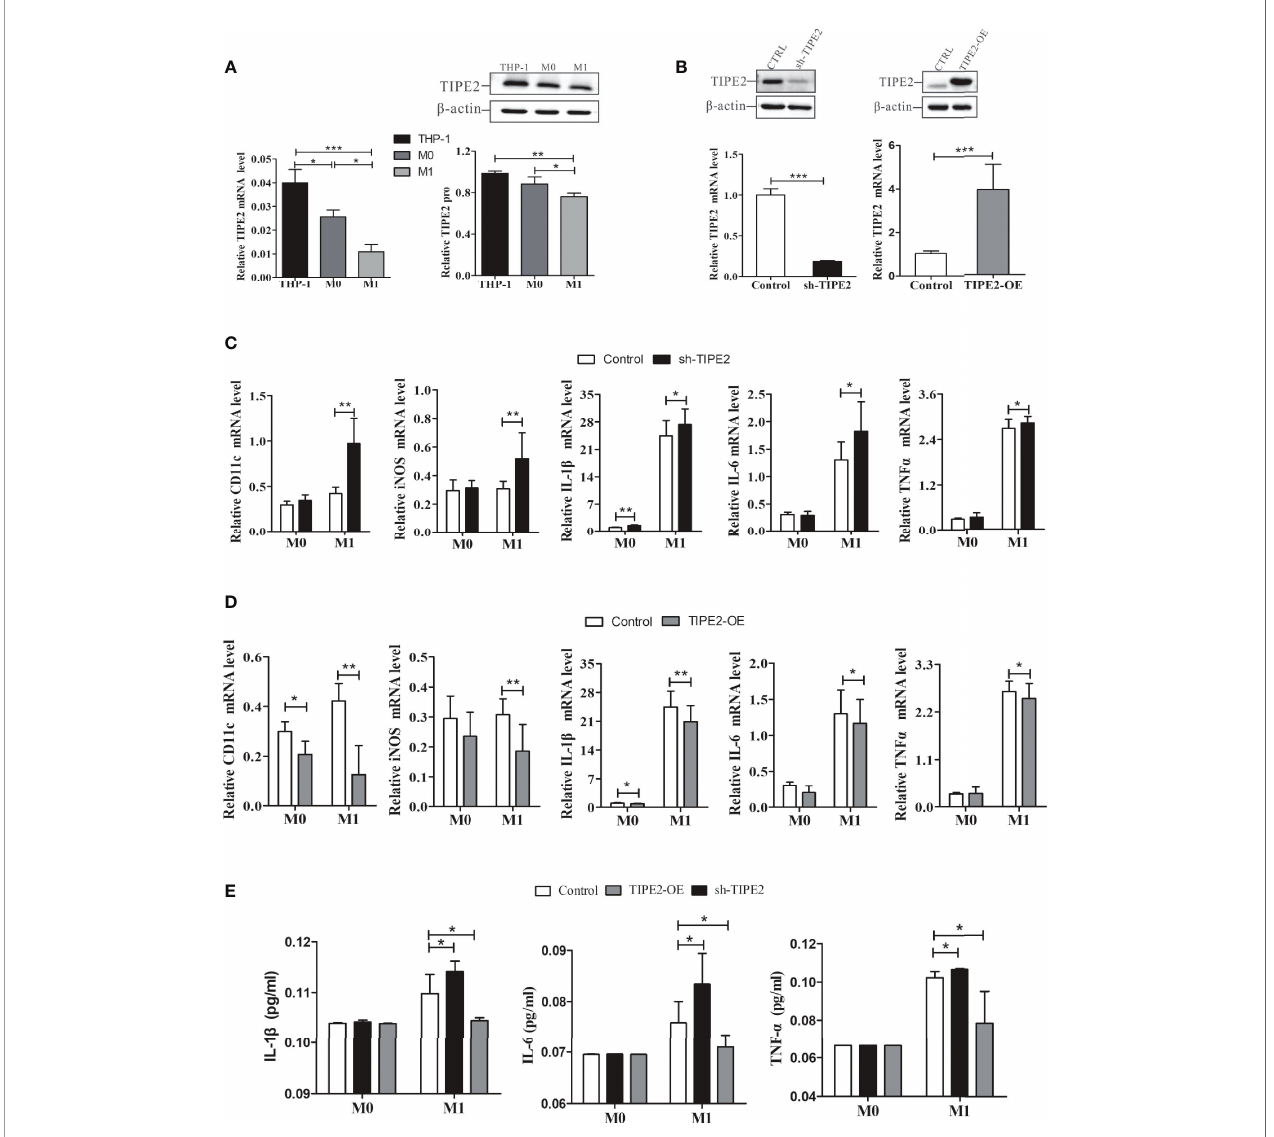
FIGURE 5 | TIPE2 impeded M1 macrophage differentiation and inhibited the expression and release of related in fl ammatory cytokines. (A) TIPE2 expression was down- regulated in M1 macrophages. TIPE2 expression levels were detected by RT-qPCR and western blotting analysis. (B) THP-1 monocytes were transduced with lentivirus expressing TIPE2 shRNA or TIPE2 overexpression sequences. TIPE2 expression levels were determined by the same method as above. (C, D) Expression of M1 genes in THP-1 monocytes by RT-qPCR following treatment with PMA (20 ng/ml) for 48 h and LPS (1 µg/ml) for 24 h. Measurements of IL-1 b , IL-6, and TNF- a mRNA expression levels in THP-1 monocytes by RT-qPCR following treatment with PMA (20 ng/ml) for 48 h and LPS (1 µg/ml) for 2 h. (E) Measurement of IL-1 b , IL-6, and TNF- a secretion in THP-1 monocytes by ELISA following treatment with LPS (1 µg/ml) for 2 h. Statistics were performed on pooled data from at least three independent experiments. Error bars represent the standard deviations of the means. A comparison of two groups was performed using Student ’ s t-test. Comparison of the means among three groups was performed using one-way ANOVA followed by post-hoc test (LSD or Tamhane ’ s T2). *P<0.05, **P<0.01, ***P<0.001. TIPE2, tumor necrosis factor a – induced protein 8 – like protein 2; RT-qPCR, reverse transcription – quantitative polymerase chain reaction; shRNA, short hairpin RNA; TIPE2-OE, TIPE2 overexpression; iNOS, inducible nitric oxide synthase; IL, interleukin; TNF- a , tumor necrosis factor- a ; LPS, lipopolysaccharide; PMA, phorbol-12-myristate-13-acetate; CTRL, control vector; ANOVA, analysis of variance; LSD, least signi fi cant